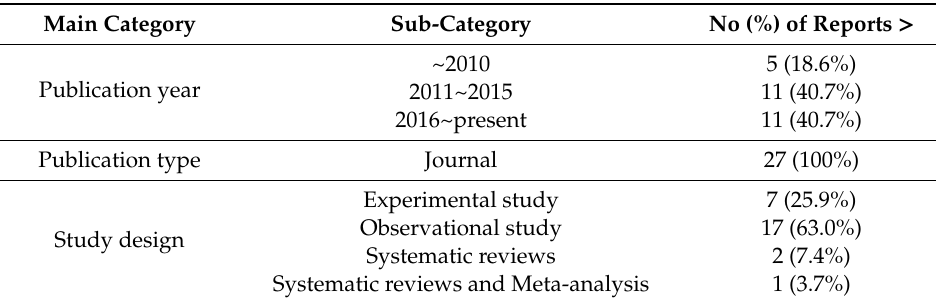
Table 7. Characteristics of the analyzed studies ( n = 27).